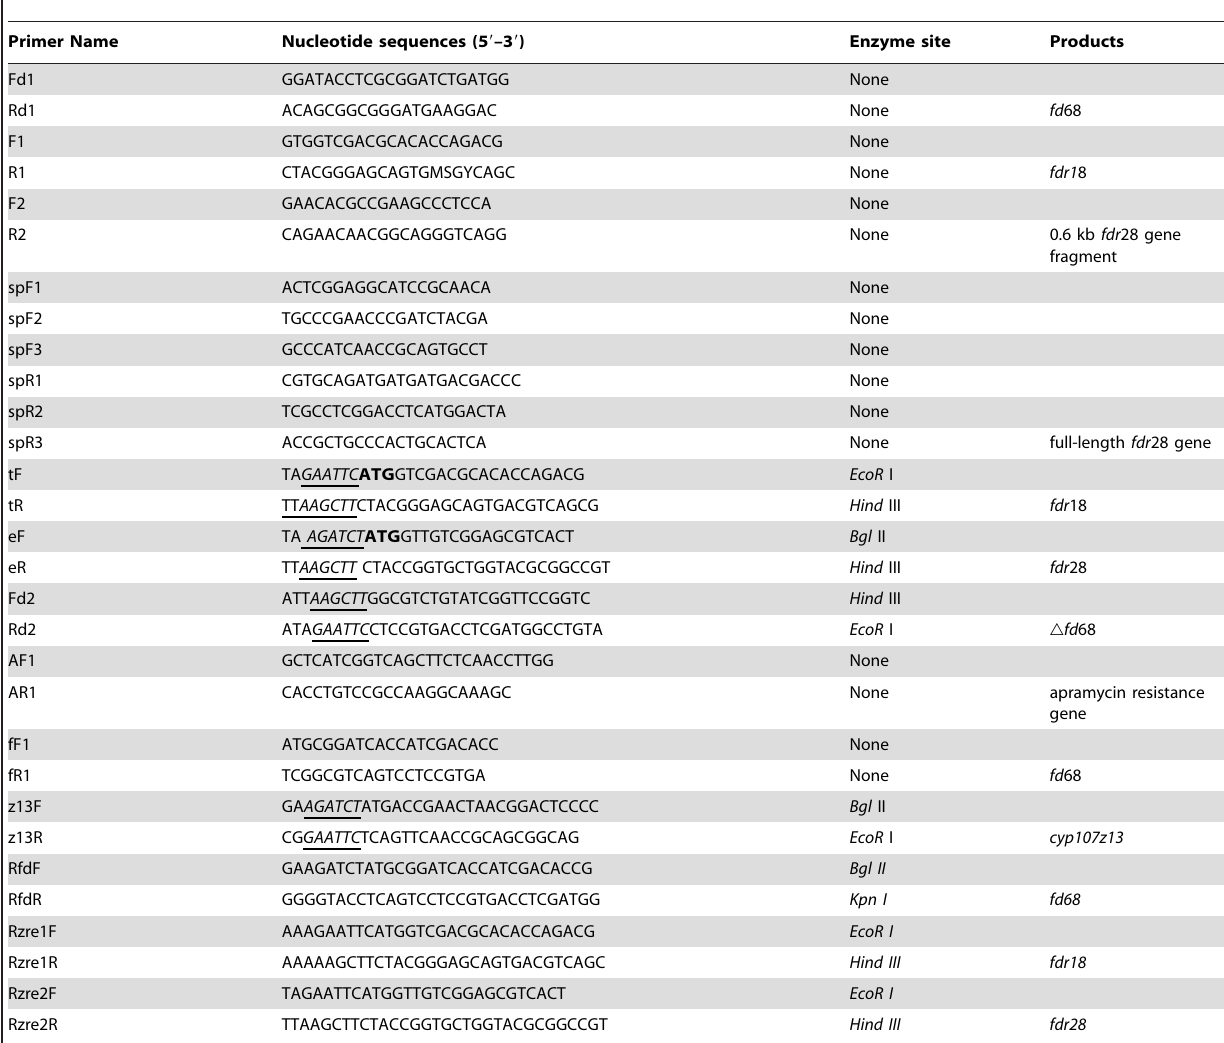
Table 2. Primers used for PCR in this